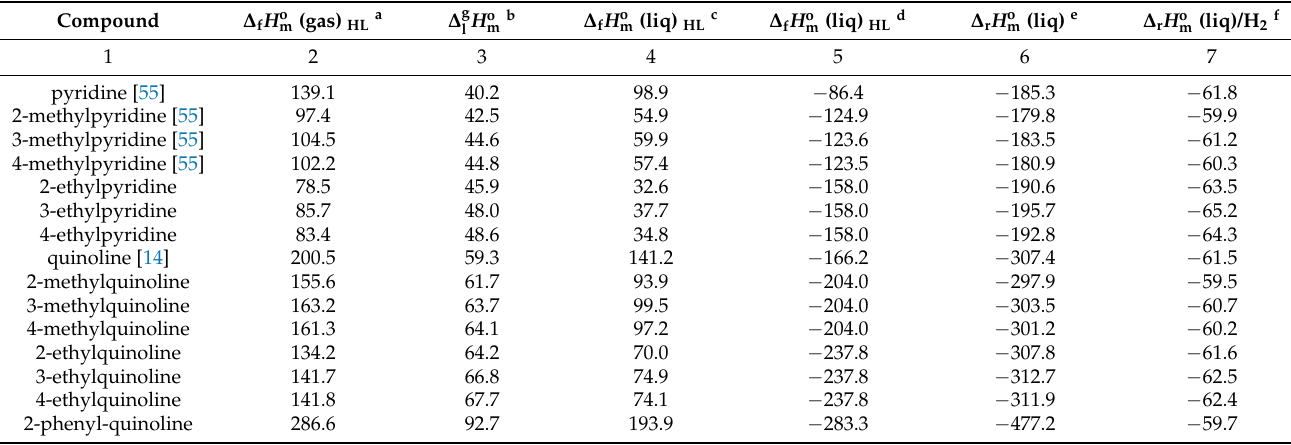
Table 11. Calculation of the liquid-phase reaction enthalpies, ∆ r H o m (liq), of the dehydrogenation of pyridines to piperidines and quinolines to decahydroquinolines, at T = 298.15 K ( p ◦ = 0.1 MPa, in kJ · mol − 1 ) a . Compound